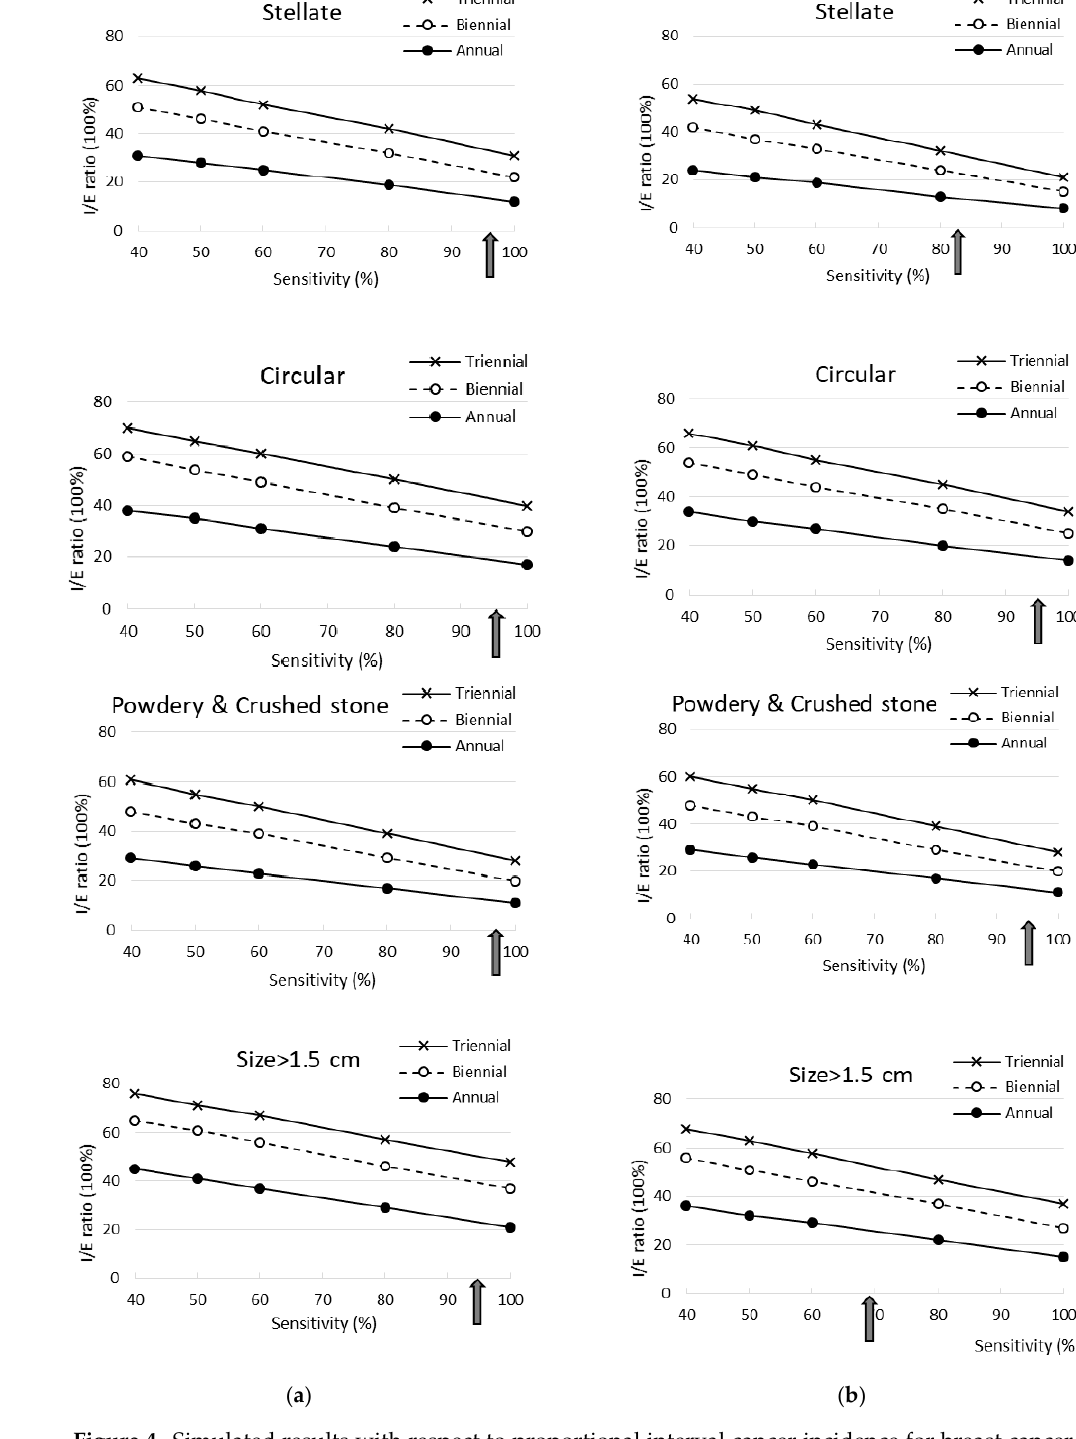
Figure 4. Simulated results with respect to proportional interval cancer incidence for breast cancer between 1977 and 1985 varying with inter-screening interval and sensitivity (arrows indicated the estimated sensitivity in this study). ( a ) 1996–2010; ( b ) 1977–1985.